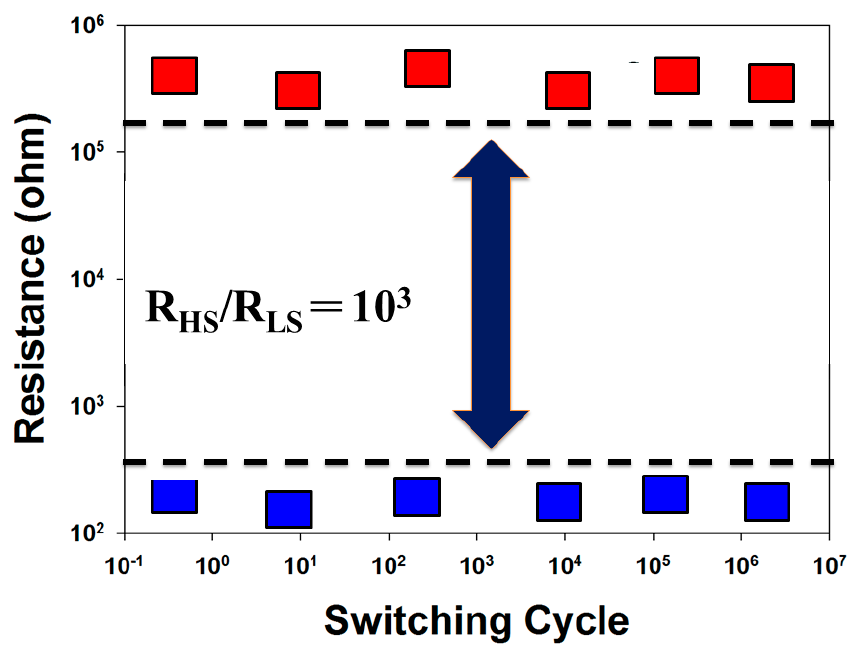
Figure 8. The resistance value versus time curves of the vanadium thin film RRAM